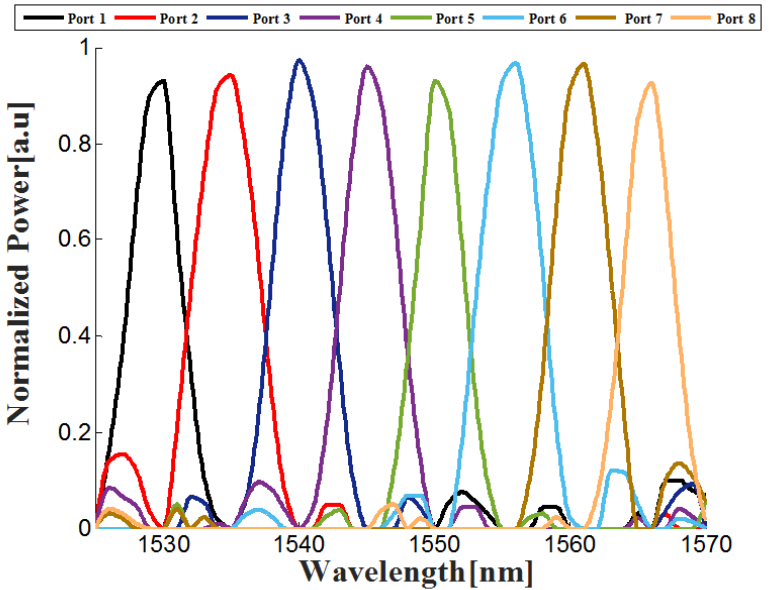
Figure 5. Normalized power as function of the optical signals.